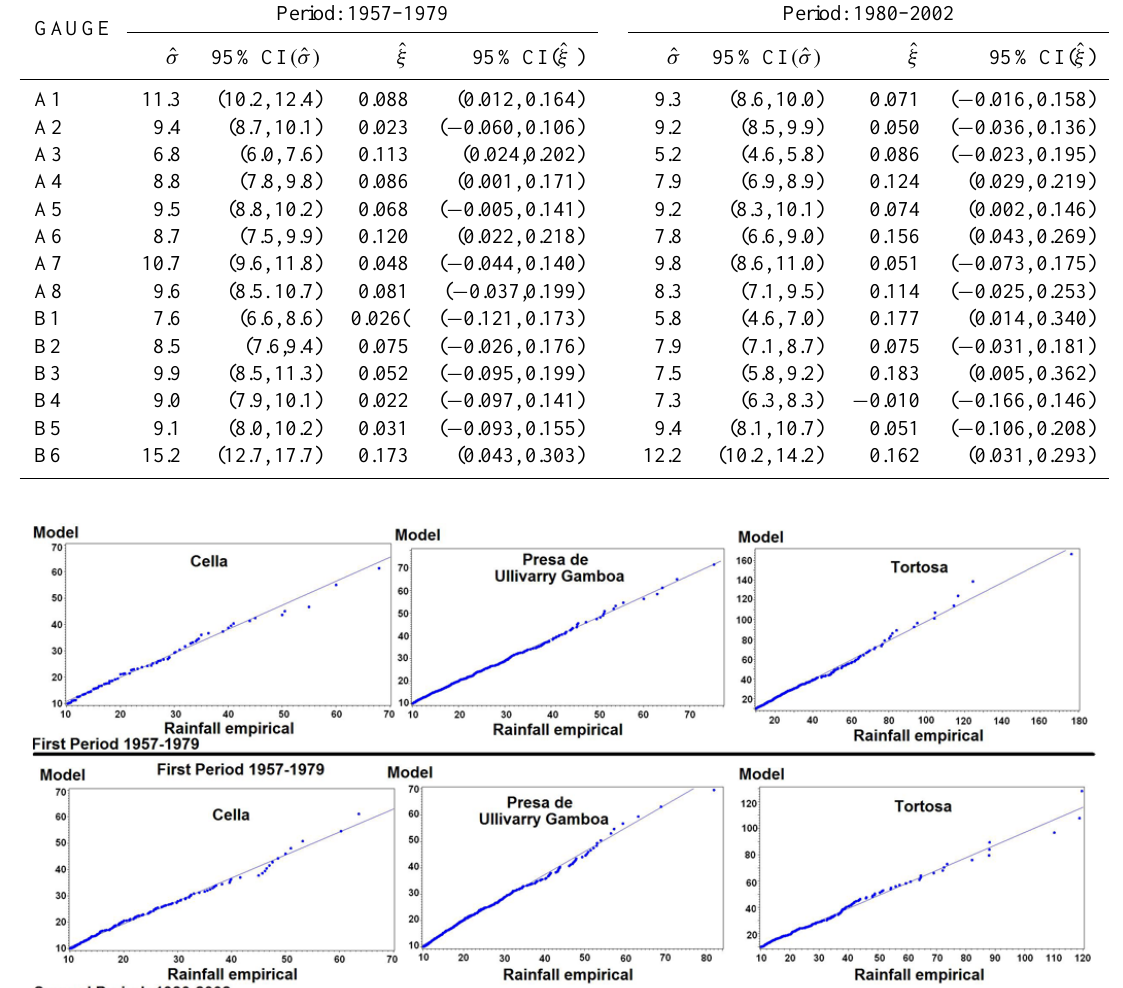
Fig. 5. The q-q plots showing model departures at Cella, Presa de Ullibarri-Gamboa and Tortosa. At the top, the first period (1957–1979) and at the bottom, the second one (1980–2002).